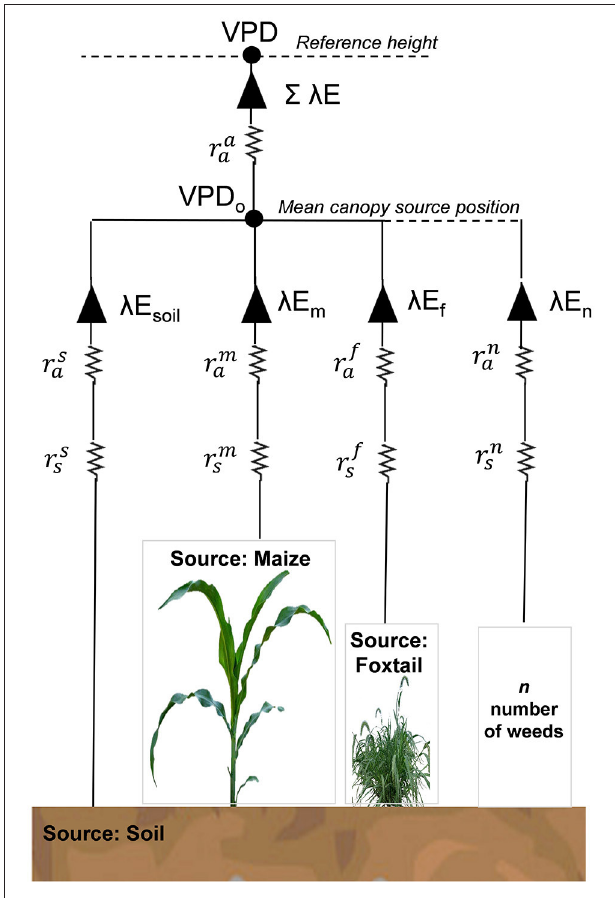
FIGURE 6 | A schematic representation of the evapotranspiration (ET) from a weed-crop system. In this particular example, constituents i are soil (superscript s ), maize crop (superscript m ), and foxtail species (superscript f ), with the possibility of extension to n number of weed species. Each species has its own canopy resistance ( r i s ) and boundary layer resistance ( r i a ). Each constituent i has its component latent heat fluxes (evaporation for soil component), λ E i , that converge within the mixed canopy where the vapor pressure deficit is VPD o . The total latent heat flux λ E mixes with the air at reference height via the aerodynamic resistance, r a a